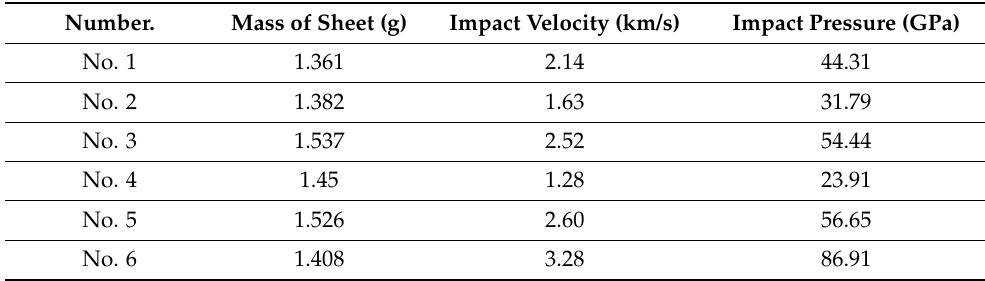
Table 2. The shock compression loading parameters at different impact